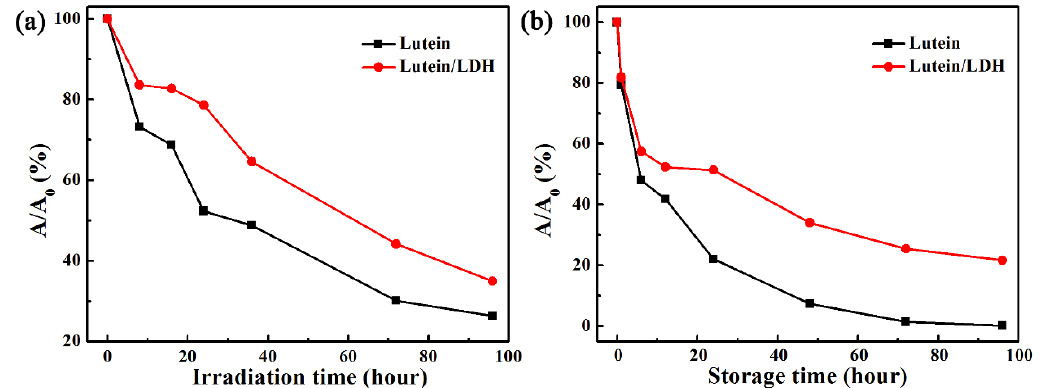
Figure 5. ( a ) photo-resistance and ( b ) storage stability of lutein and lutein/LDH with different exposure time.